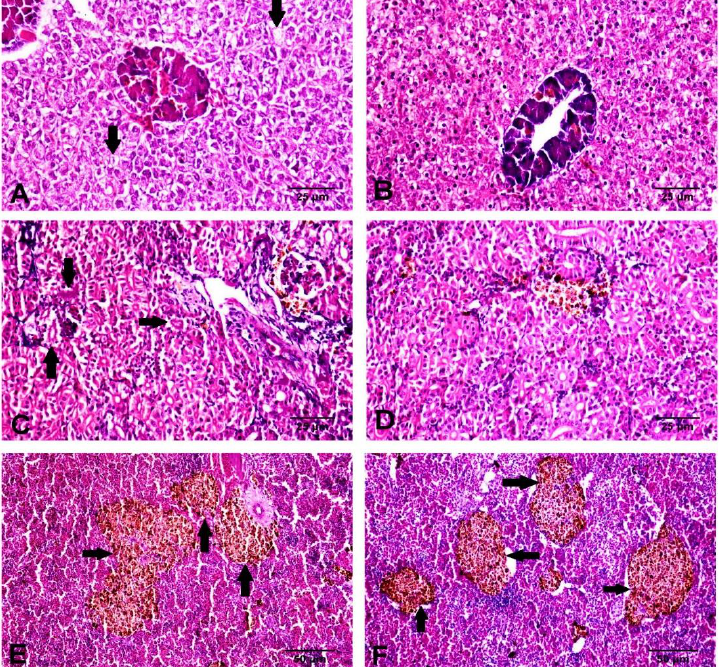
Figure 6. Histological examination of the liver, kidney, and spleen in the control and Hilyses-treated groups. ( A ). Liver of the control group showing vacuolation of hepatocytes (arrow) (H&E ×400); ( B ). Liver of the Hilyses-treated group showing normal histological characteristics of hepatocytes (H&E ×400); ( C ). Kidney of the control group showing necrosis of some renal tubular epithelium (arrow) (H&E ×400); ( D ). The Hilyses-treated group showing normal histological architecture of the kidney (H&E × 400); ( E ). Spleen of the control group showing moderate activation of MMCs (arrow) (H&E × 200); ( F ). Spleen of the treated group showing marked activation of MMCs (arrow) (H&E × 200).